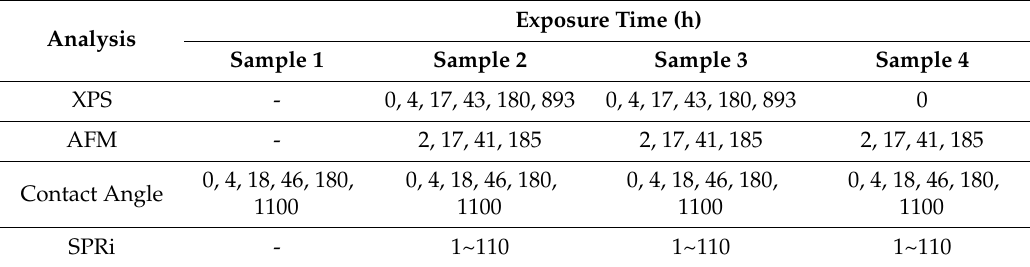
Table 2. Surface characterization methods used to study the surface properties of the